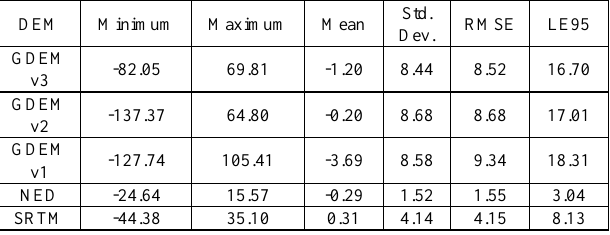
Table 1. Error statistics (meters) from accuracy assessments vs. NGS GPS